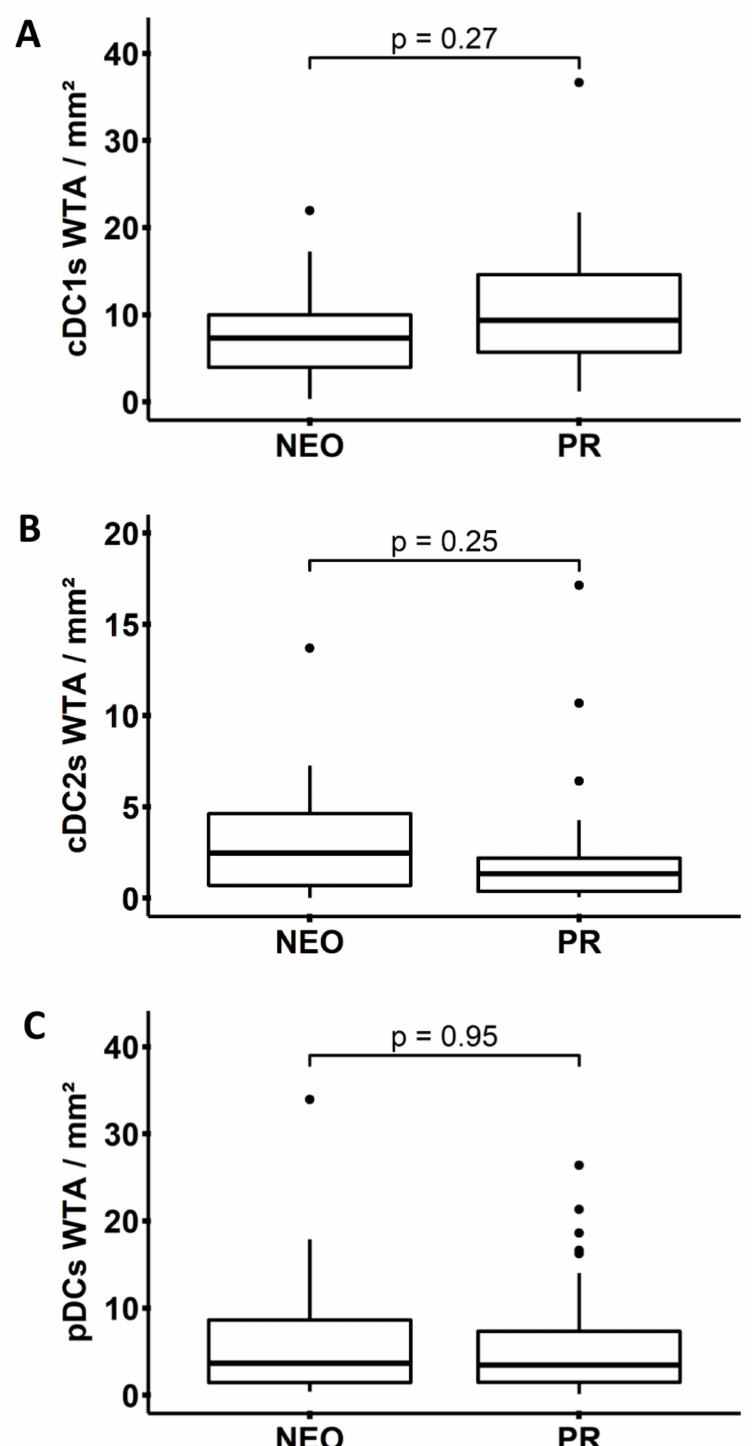
Figure 6. Effect of neoadjuvant chemotherapy (NEO) on the frequency of dendritic cells (DCs) within the whole tumor area (WTA) of pancreatic ductal adenocarcinoma (PDAC) patients. Boxplots show the frequencies of ( A ) conventional DCs type 1 (cDC1s) ( n = 40), ( B ) type 2 (cDC2s) ( n = 40), and ( C ) plasmacytoid DCs (pDCs) ( n = 58) in patients treated with NEO or primary resection (PR). Significances were tested using the Mann–Whitney U test. p ≤ 0.05 was considered